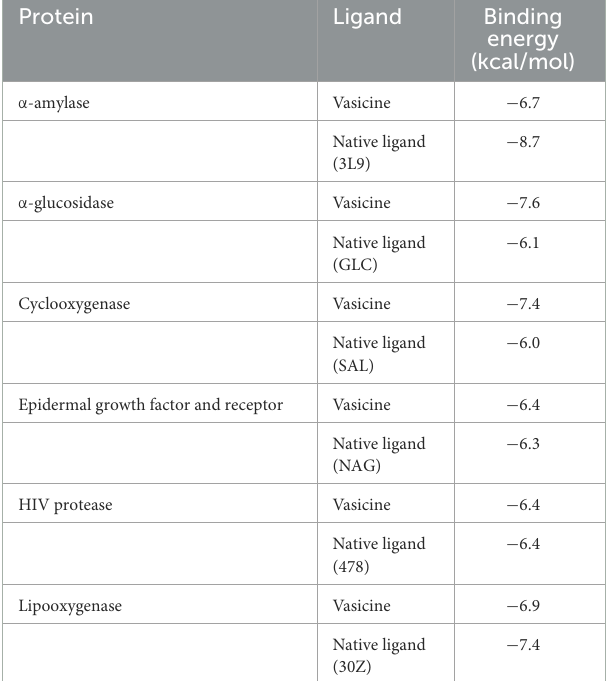
TABLE 2 Binding affinity of vasicine in comparison to the native ligand of different proteins. Protein Ligand Binding